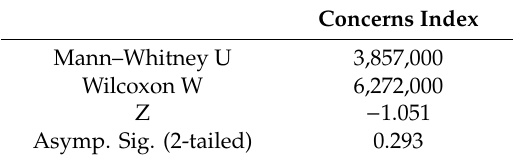
Table 15. Mann–Whitney U Test Statistics concerns index and city.